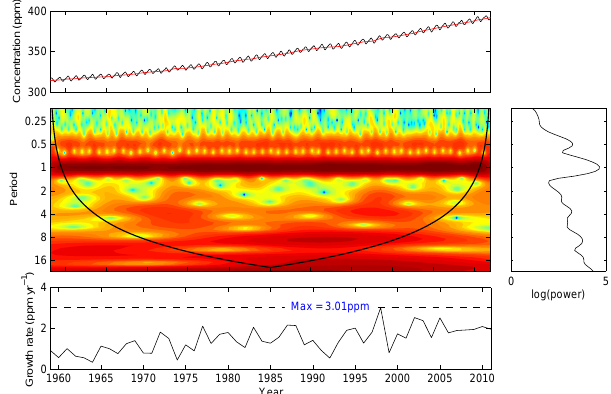
Figure A1. Top row: weekly mean (black) and low-pass filtered (red, periods > 18months) CO 2 mole fraction time series (ppm) at Mauna Loa, 1959–2012. Middle row: (left) the wavelet power spec- trum where the colour scale is log (power). The black solid lines de- notes the cone of influence. The power spectrum tends to emphasise very low frequency information so we have subtracted an exponen- tial term prior to applying the wavelet transform to emphasise the high frequency variability (right) the corresponding time-integrated power spectrum. Bottom row: the inferred annual growth rate of CO 2 (ppmyr − 1 ).